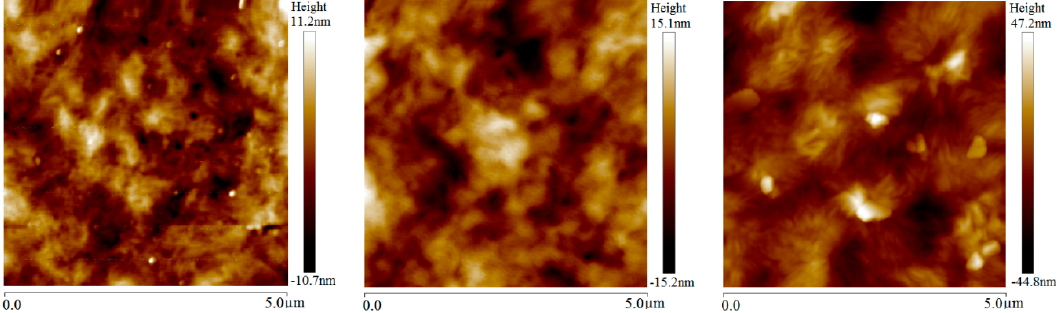
Figure 4. AFM images of 2 wt % micron-BiFeO 3 /LDPE composites without magnetization (left panel) and magnetized at room (middle panel) and elevated (right panel) temperatures.